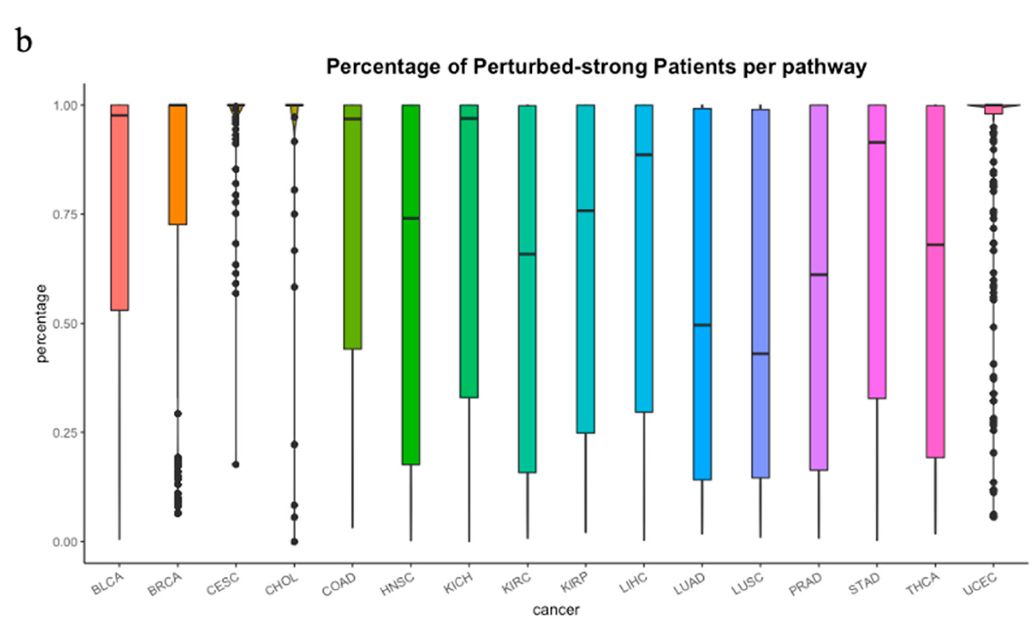
Figure 4. The violin plot of perturbations in each cancer. ( a ) The percentage of perturbed-strong pathways per patient in 16 cancer types. Different colors represent different patient samples of each cancer type. Cervical squamous cell cancer (CESC) and cholangio cancer (CHOL) showed 97% and 96% perturbed pathways, respectively. Breast cancer (BRCA) and uterine corpus endometrial cancer (UCEC) also had high proportions, which were both over 80%. ( b ) The percentage of perturbed-strong patient per pathway. High percentages were observed in CESC, CHOL and UCEC, which were near 100%. The percentages in LUAD and LUSC were below 50%.